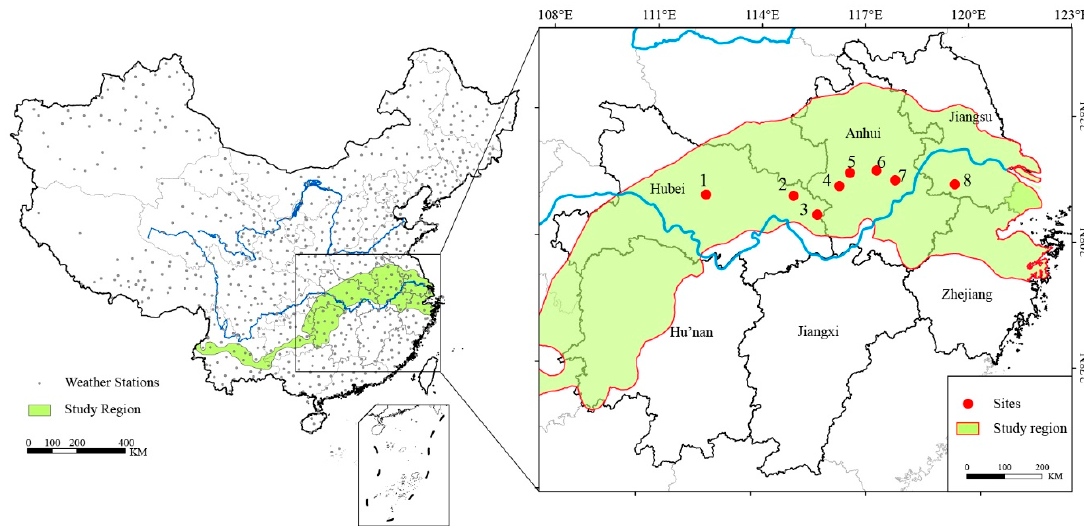
Figure 1. The study region, the selected 8 rice experimental sites (Red dots), and the locations of meteorological stations (black points) in the middle and lower reaches of the Yangtze River in China.